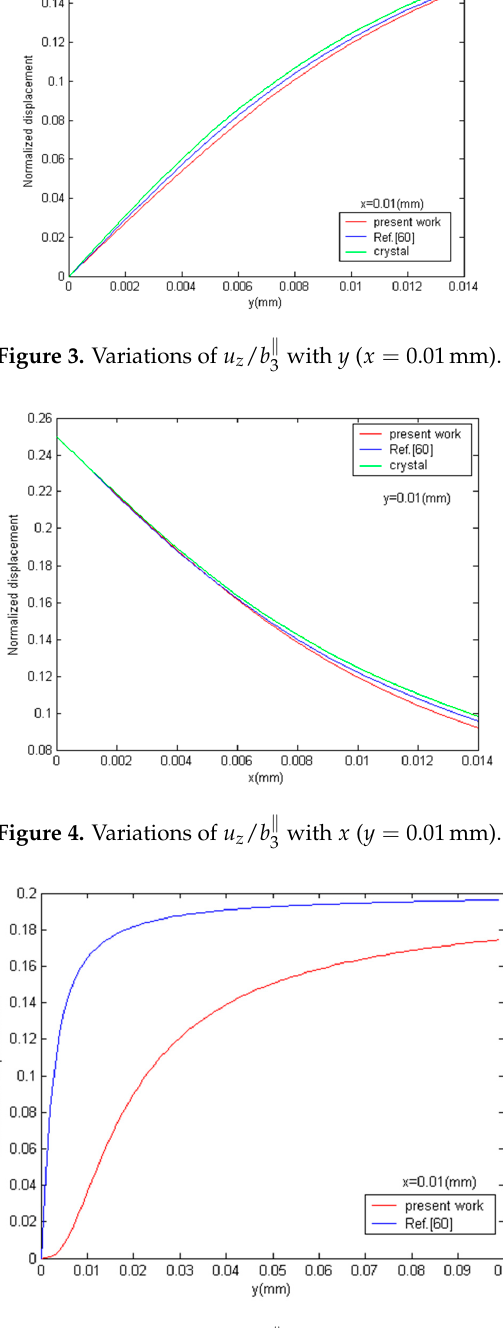
Figure 5. Variations of w z / b